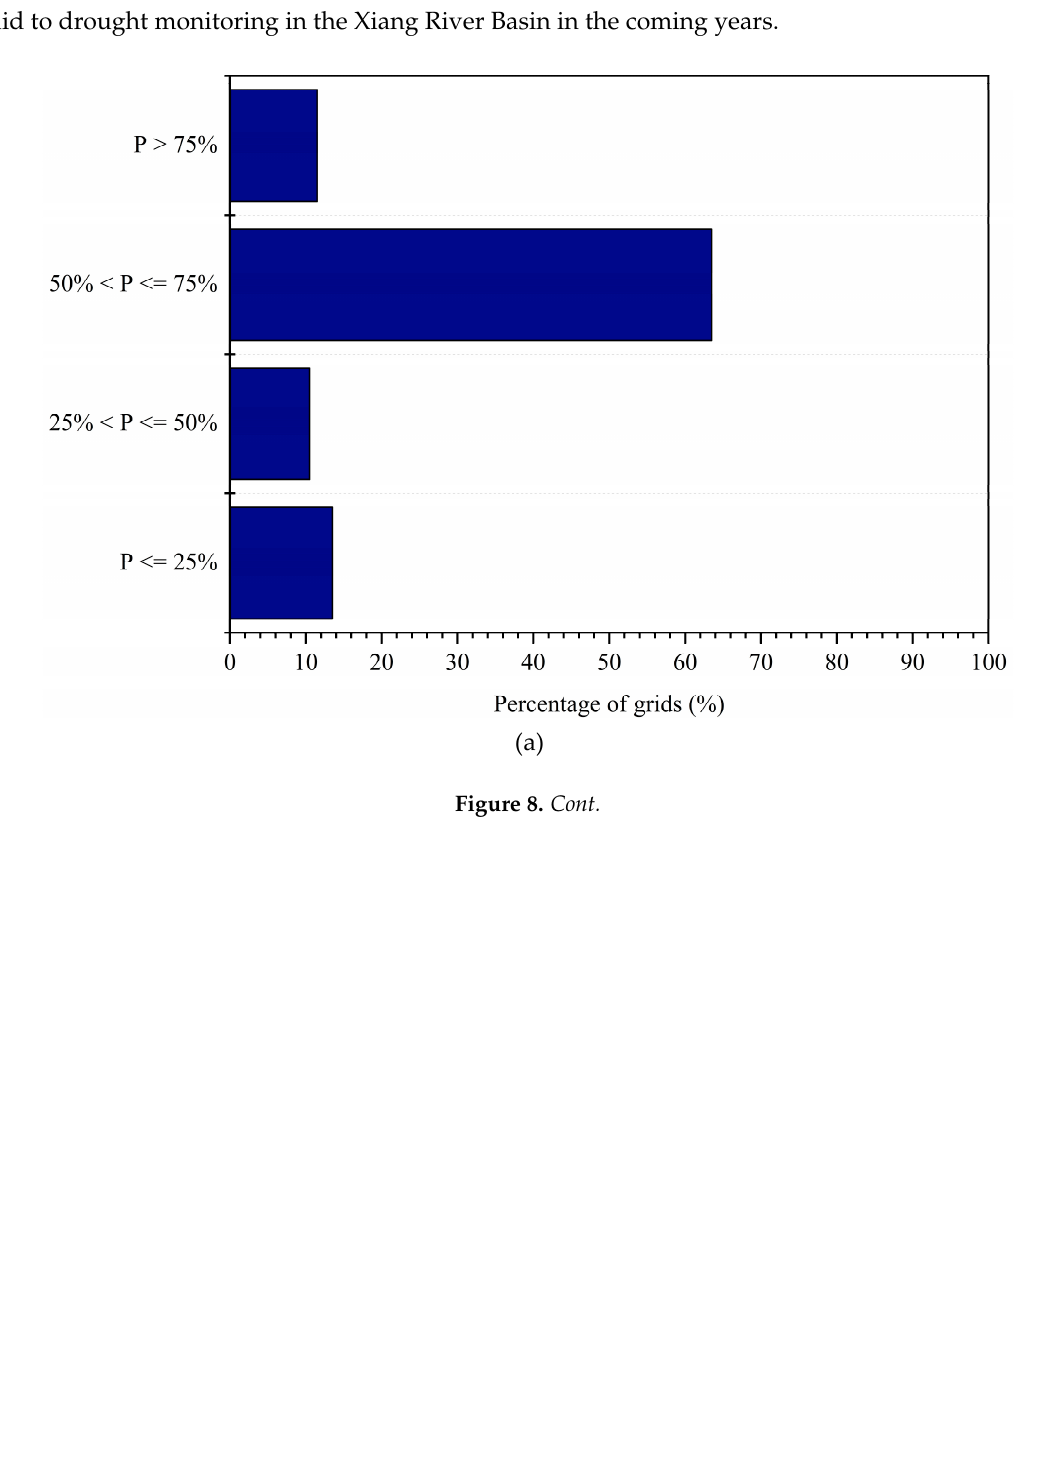
Figure 7. Spatial distribution of percentage of drought weeks (PDWs) (%) in 2015 ( a ), 2016 ( b ), and 2017( c ),